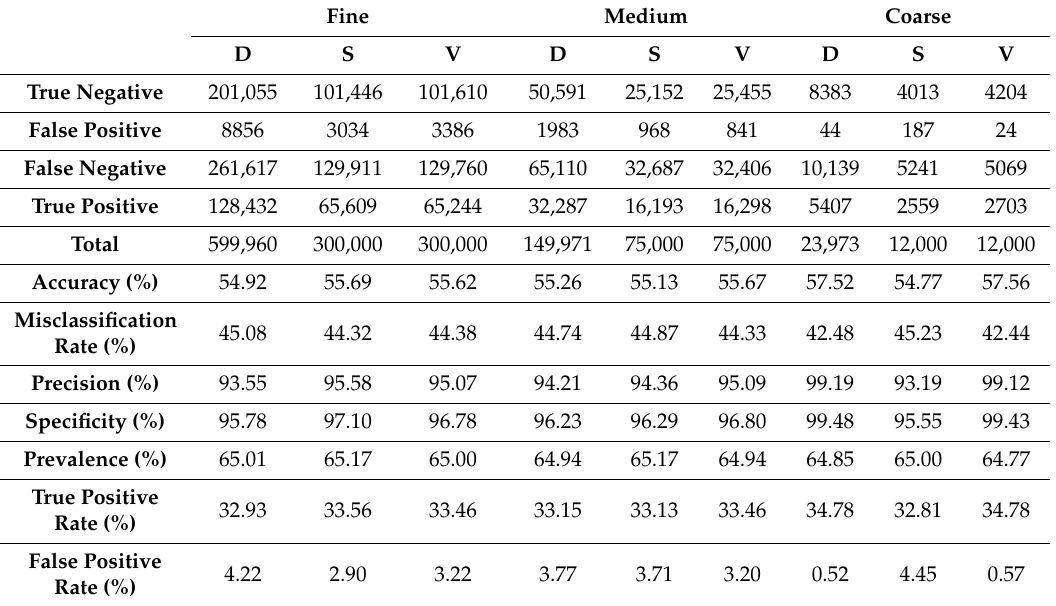
Table 11. Verification from confusion matrix by sizes, fine, medium, coarse, as well as shapes, such as Delaunay (D), Square (S) and Voronoi